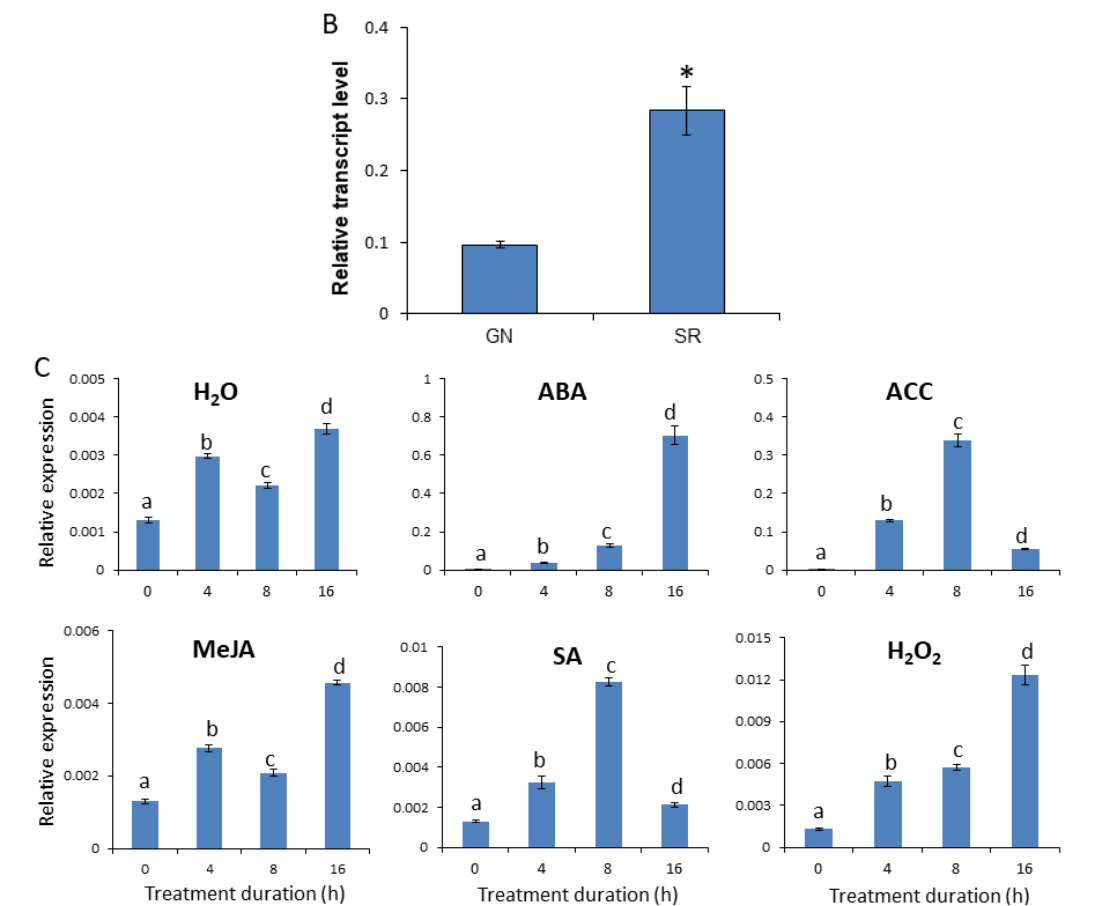
Figure 4. Identification of the target ApMYB1. ( A ) Alignment of ApMYB1 and eleven reference MYB TFs with known function of promoting anthocyanin biosynthesis. Black shading indicates identical amino acids. The R2 and R3 domains were indicated with black lines. The motif for bHLH binding and ANDV motif in R3 domain were enclosed with dotted rectangles a and b, respectively. The KP[Q/R]PR[S/T]F motif downstream of R3 domain was enclosed with dotted rectangles c. ( B ) The relative transcript level of ApMYB1 in green and semi-red leaves measured by qPCR. ( C ) Responses of ApMYB1 transcription to exogenous chemical treatments. Excised Acer palmatum leaves were incubated under light with H 2 O (negative control), ABA (20 μ M), ACC (precursor of ethylene, 50 μ M), MeJA (50 μ M), SA (100 μ M) and H 2 O 2 (1%). Values in ( B , C ) are means ± SD ( n = 3). In ( B ), the asterisk indicates a significant difference between transcript levels of semi-red (SR) and green leaves (GN) ( p < 0.05). In ( C ), different lower-case letter indicates significant difference among values at different treatment durations ( p < 0.05).